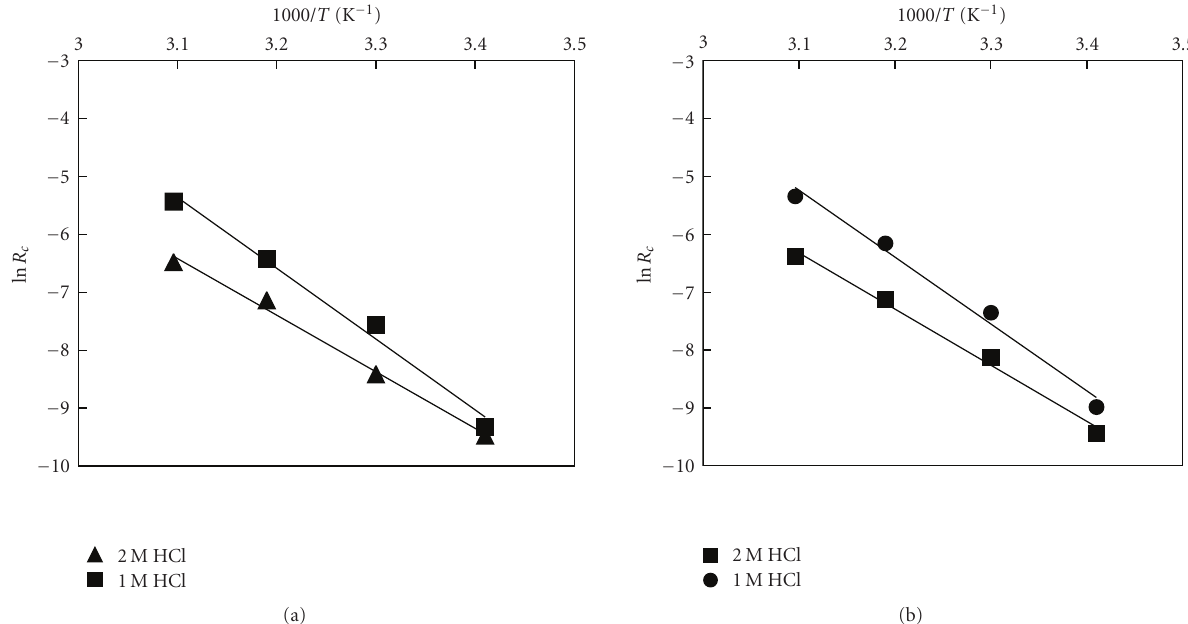
Figure 3: Arrhenius plot of ln R c versus reciprocal temperature ( 1/T ) for (a) [LAS] = 0.0 ppm and (b) [LAS] = 1000ppm at di ff erent HCl concentrations.